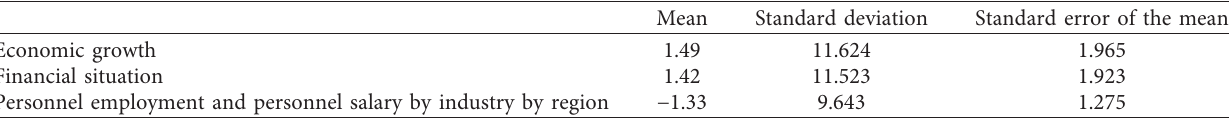
Table 14: IBk algorithm risk assessment system analysis table of